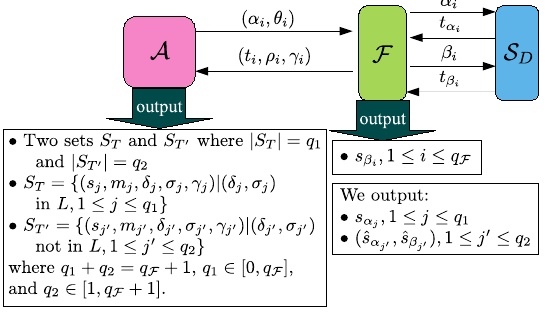
Figure 6. The model of the proof for